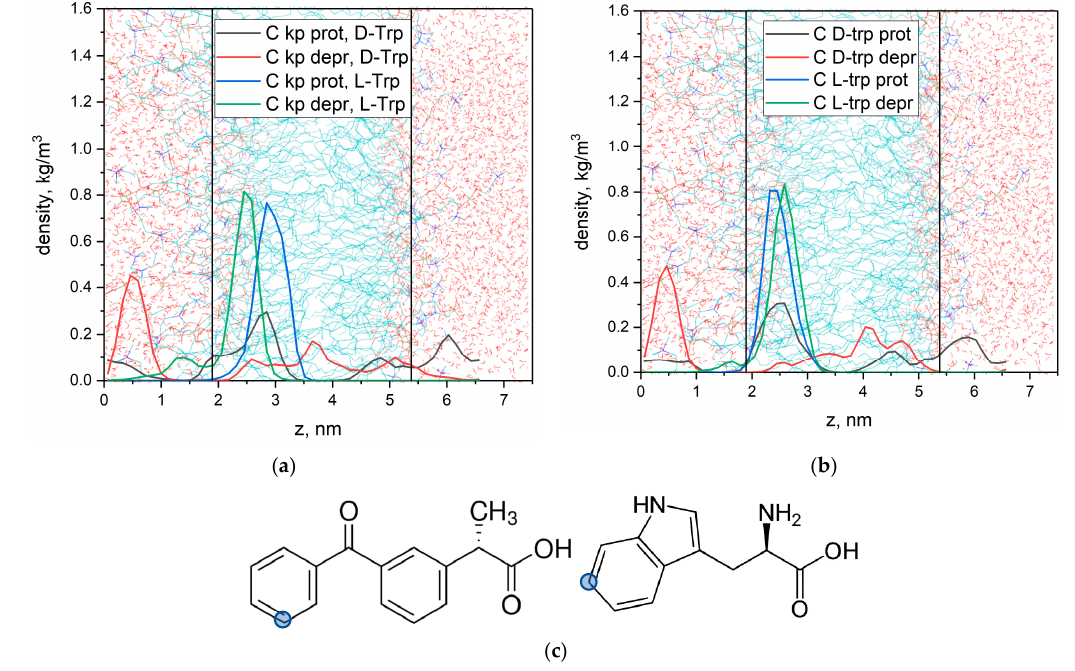
Figure 10. Density profiles of the selected C atoms of KP ( a ), L/D-tryptophans ( b ) in lipid bilayer for protonated (prot) and deprotonated (depr) states of KP and atom selections ( c ). Vertical lines correspond to the centers of density profiles of DMPC N atoms.